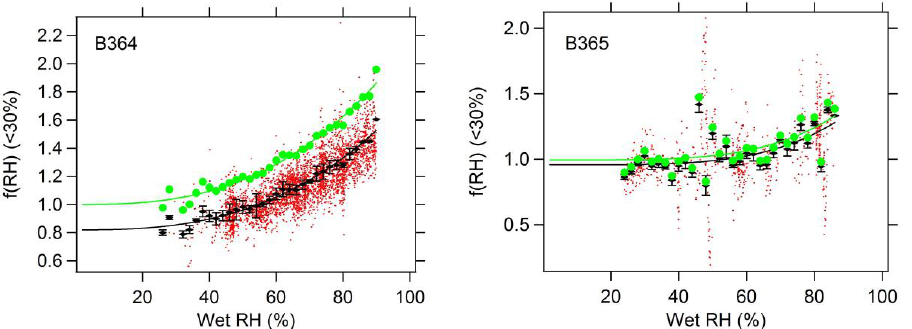
Figure 6. Humidograms constructed using the wet nephelometer measurements for the entire flights of B364 (left-hand panel) and B365 (right- hand panel), showing all data for which the dry nephelometer recorded less than 30% relative humidity (dots), 2 min averages with standard deviations (black diamonds and error bars) and the Model 2 fit to the 2 min average data (black line). Also shown by green dots is the 2 min average data rescaled to account for particle losses between the nephelometers, with the Model 2 fit to this scaled data (used for Fig. 7) shown as the green line.